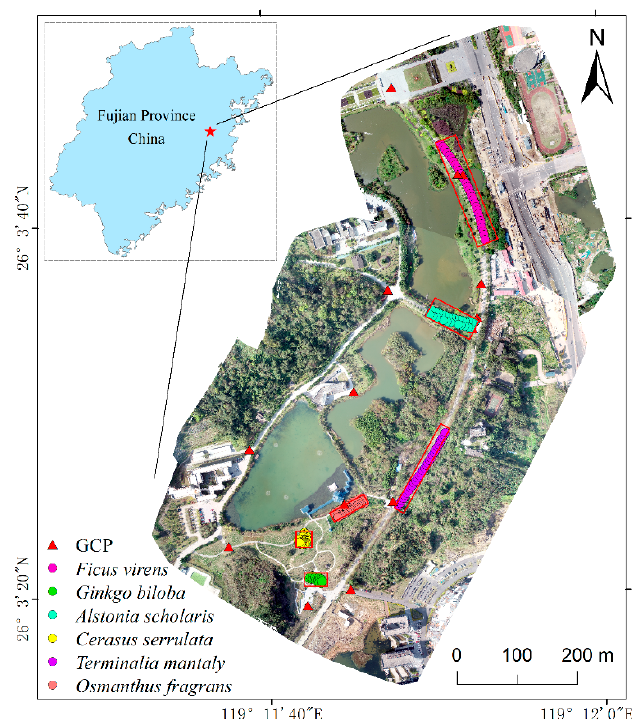
Figure 1. Study area in the Qishan Campus of Fuzhou University, China. The locations of the ground control points (GCPs) and tree samples are projected on the UAV orthophoto.